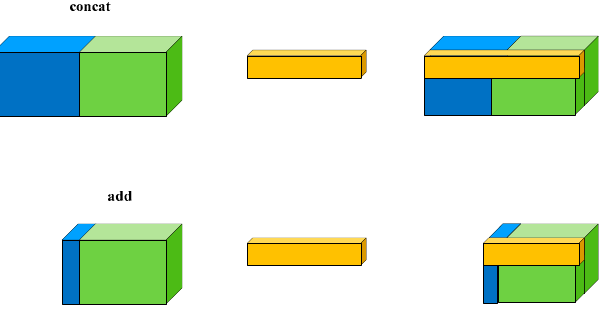
Figure 5. Feature fusion mode (All color represent features).